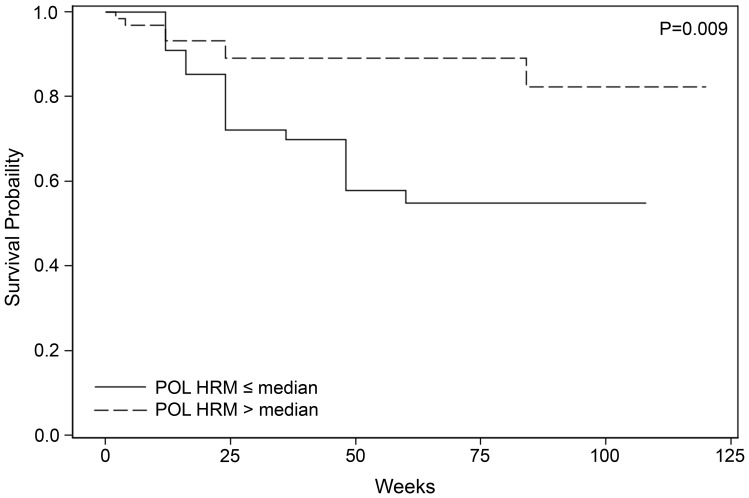
Association of POL HRM scores and time to virologic failure or death.The figure shows a Kaplan-Meier plot of time (weeks) to the composite endpoint of virologic failure or death for children with pre-treatment POL HRM scores above or at/below the median score of 4.3. The significance level is calculated from a Cox proportional hazards regression adjusted for study treatment, entry age, CD4%, and HIV viral load.